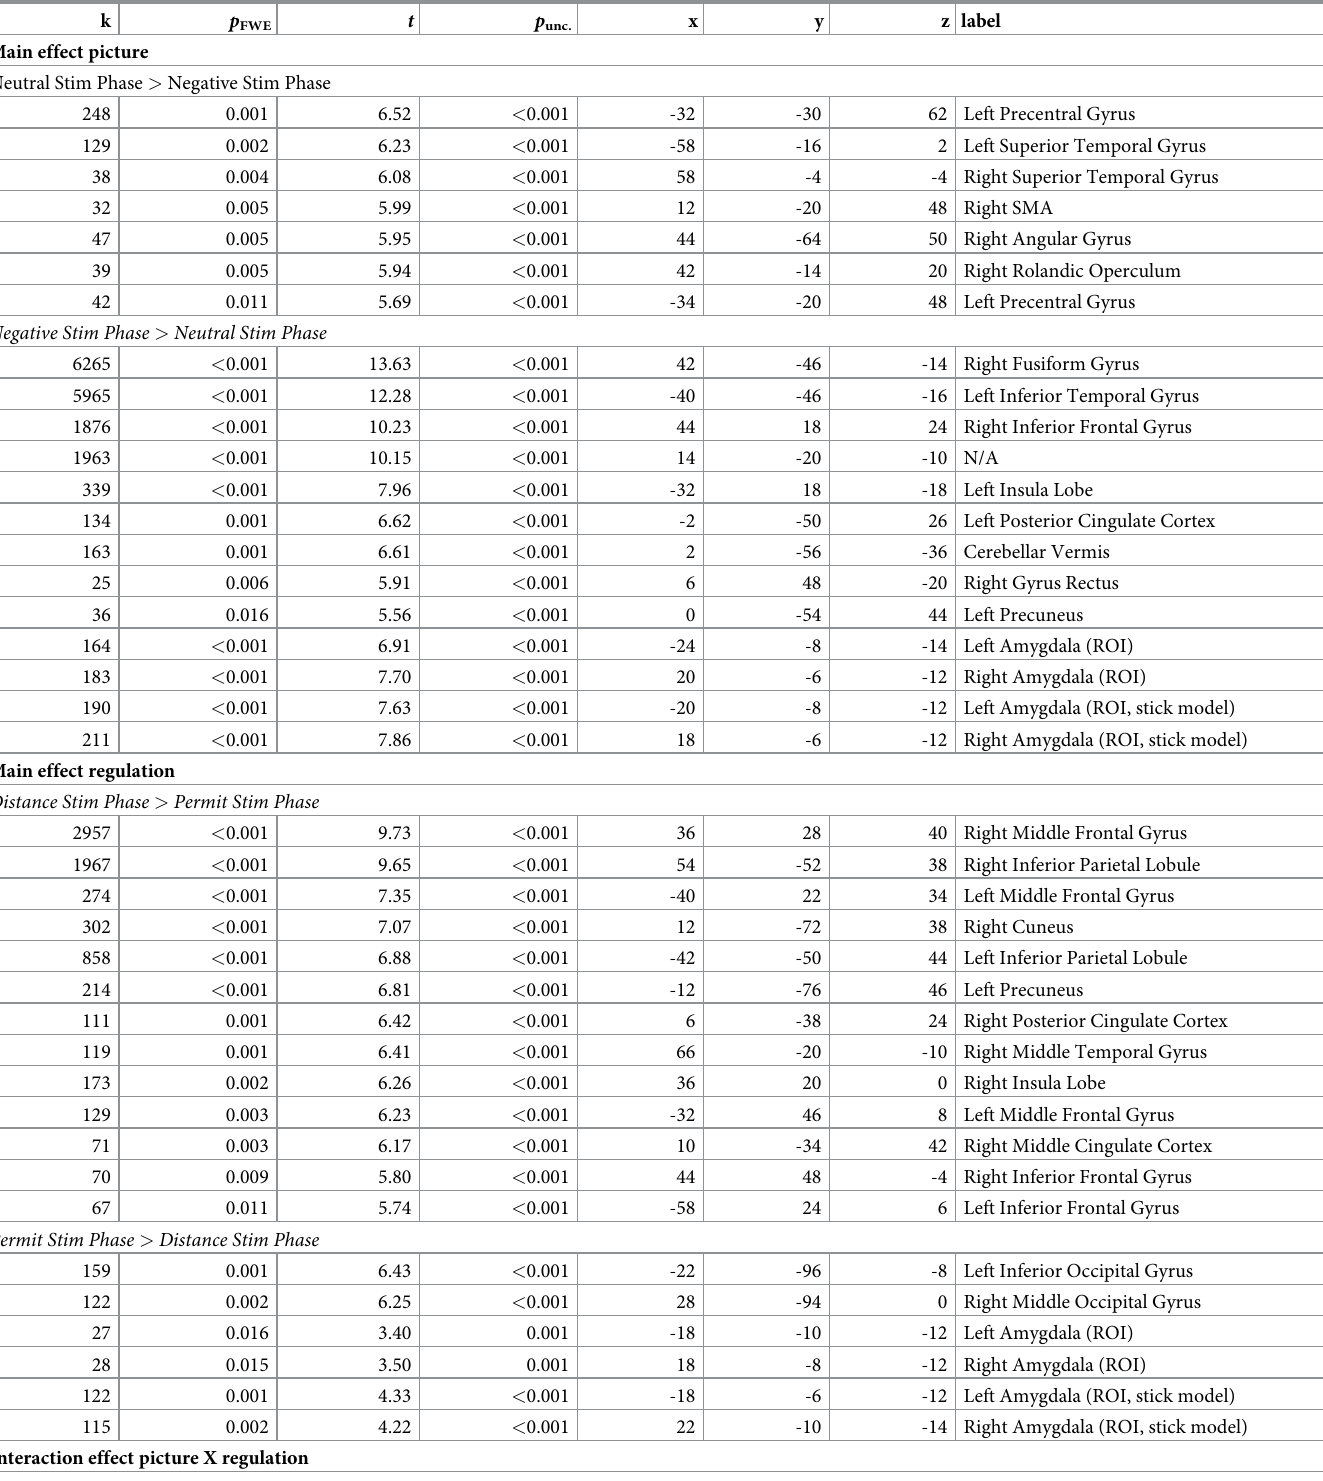
Table 1. Activation maxima in the emotion regulation task during the stimulation phase (concurrent effects, timepoint 1). k p FWE t p unc. x y z